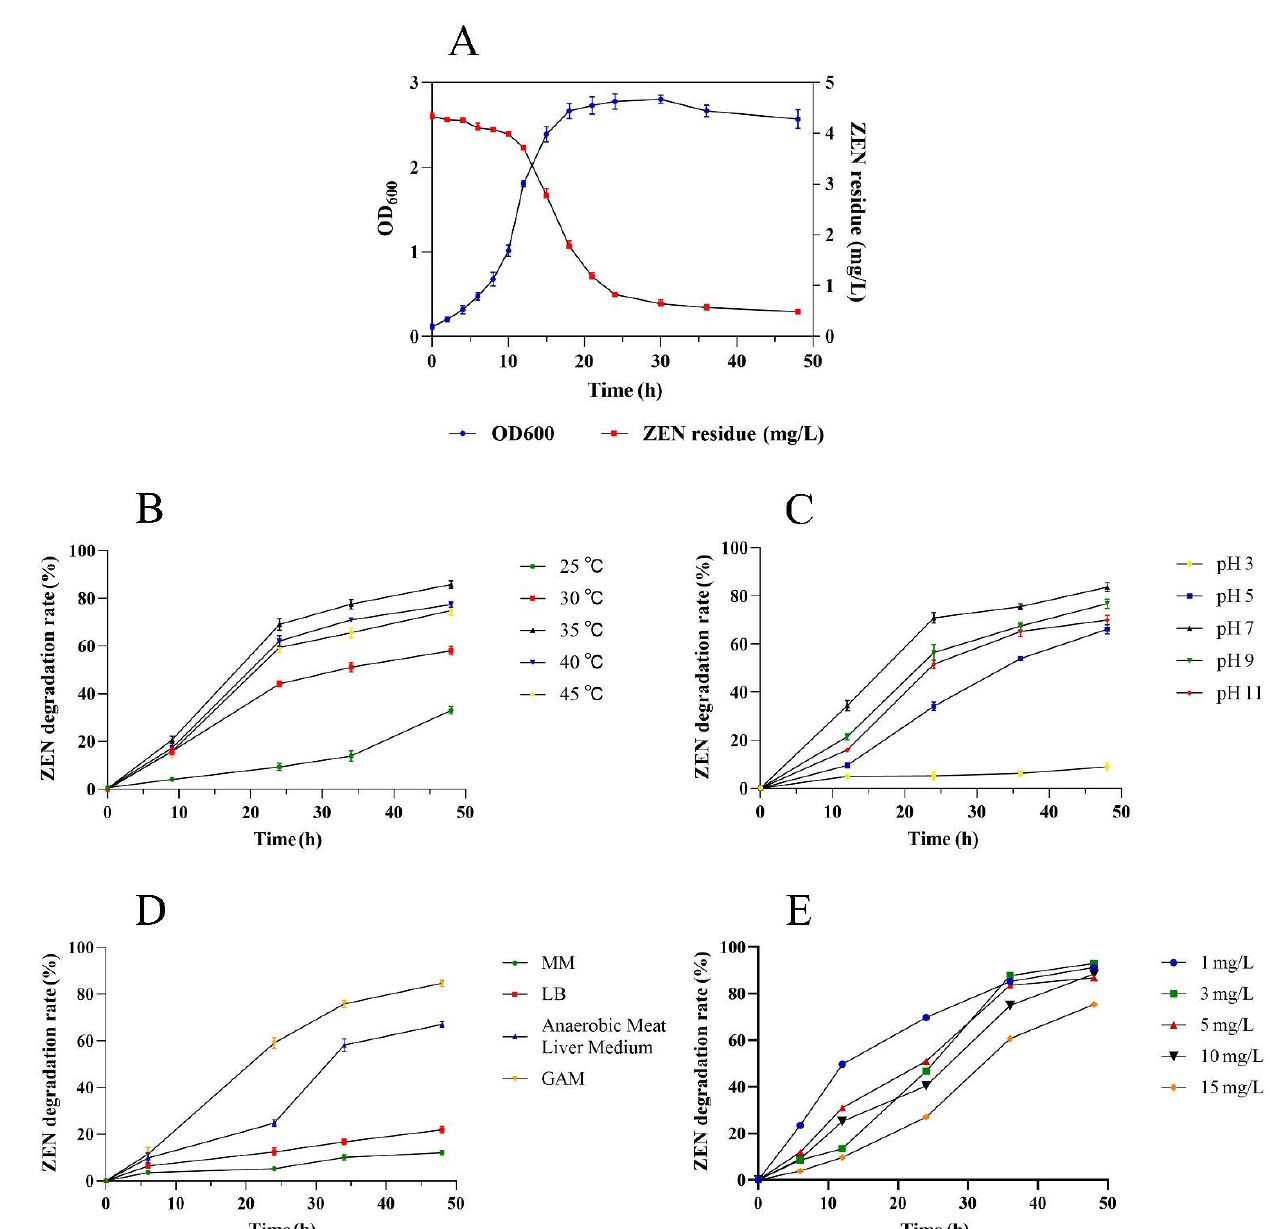
Figure 3. The growth rate of F39 and degradation of ZEN during the culture ( A ). F39 cells were inoculated at the 10% level into 20 mL of GAM containing 5 mg/L ZEN and were then cultured at 37 °C and 110 rpm in an anaerobic environment. The effect of temperature ( B ), pH ( C ), cultural media ( D ), and substrate concentration ( E ) on the degradation of ZEN by F39.